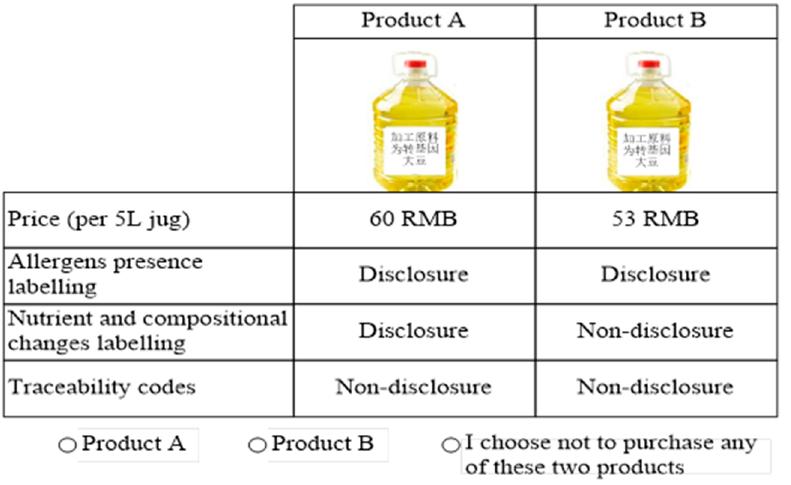
Figure 1. Example choice scenario.